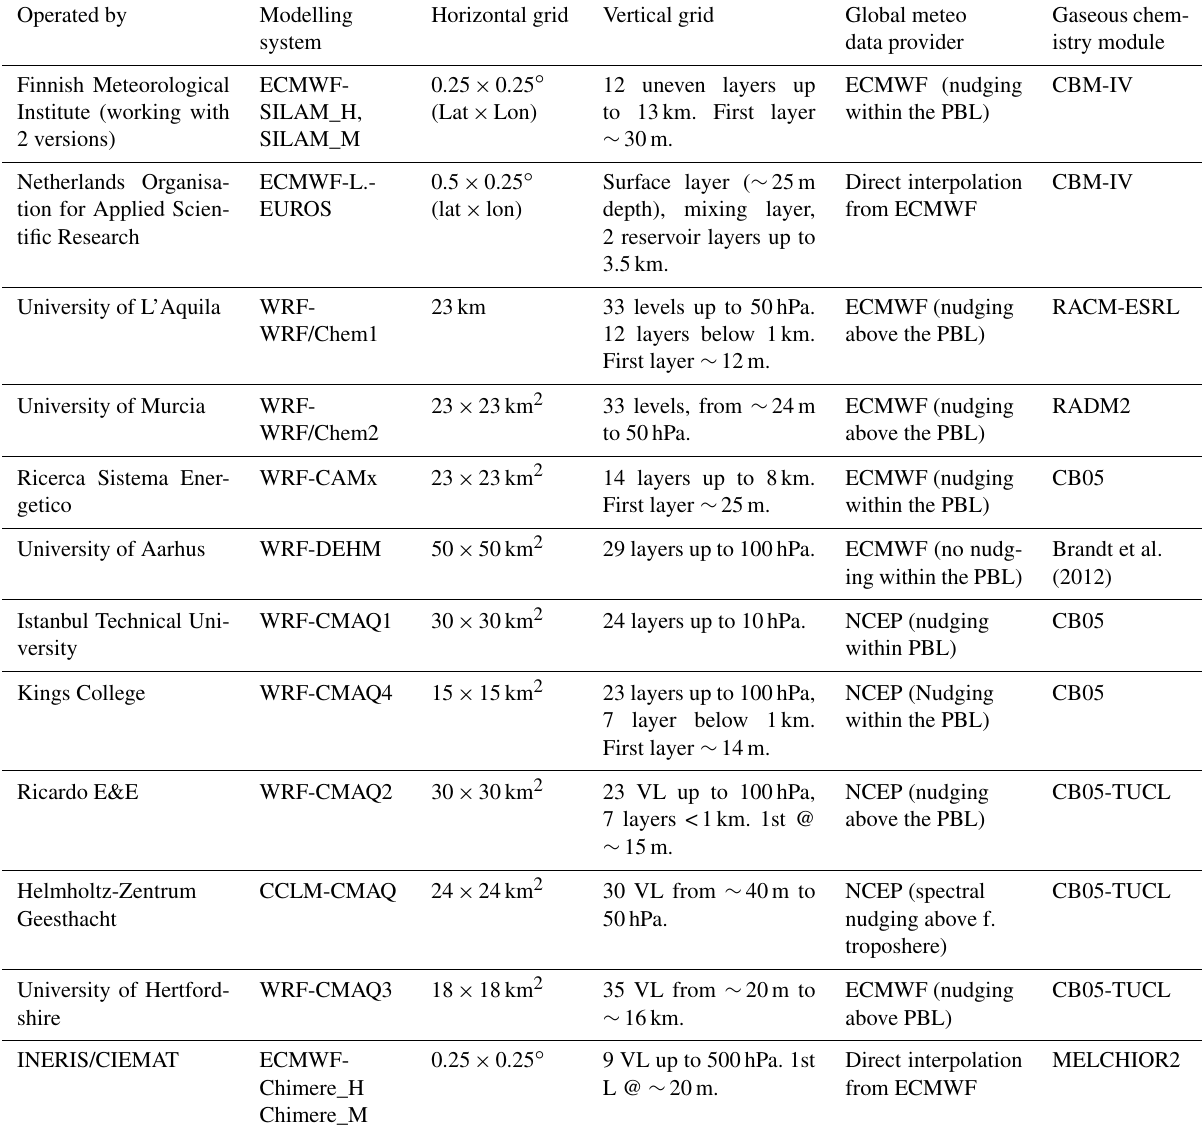
Table 1. Participating regional modelling systems and key features. Operated